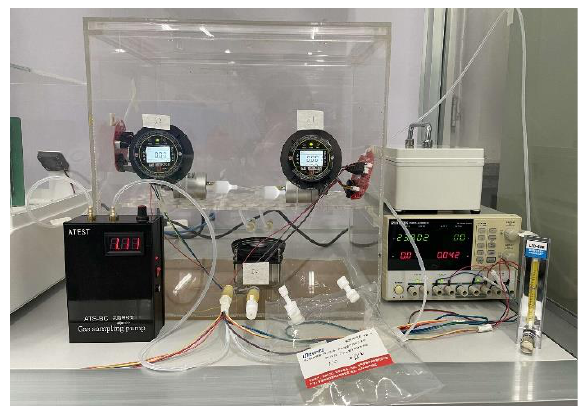
Figure 4. Experimental setup of electronic nose detection.